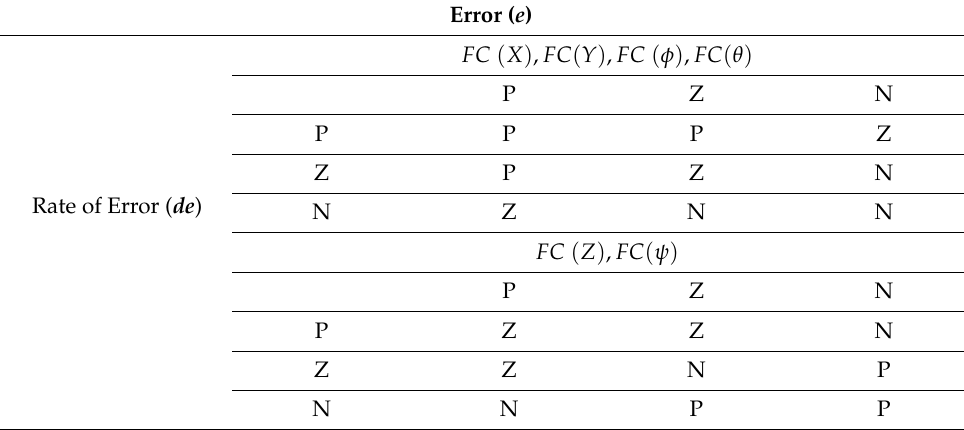
Table 4. X3D Quadrotor’s Fuzzy Rules.